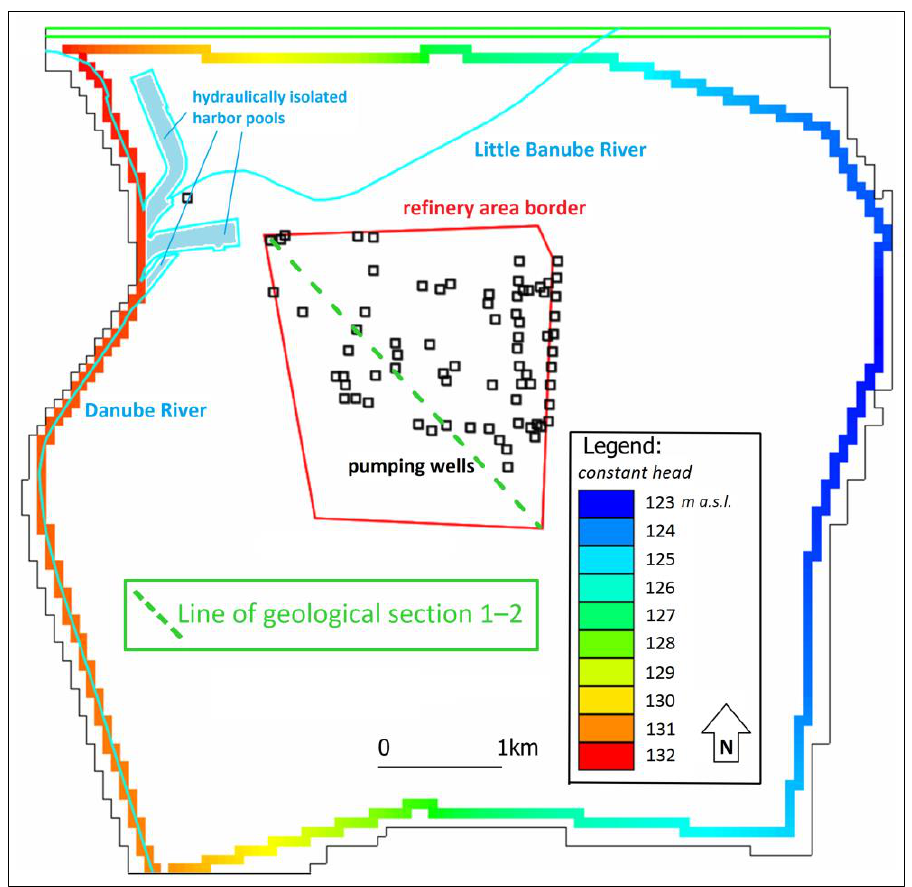
Figure 4. Constant head boundary level, pumping wells, surface water bodies and situation of the geological section 1–2 in the model domain.